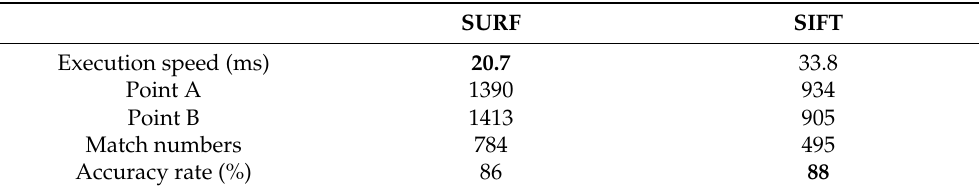
Table 1. We randomly selected two adjacent images for SIFT and SURF evaluation; point A refers to the number of feature points extracted from the previous image and point B refers to the number of feature points extracted from the latter image. SURF SIFT Execution speed (ms) 20.7 33.8 Point A 1390 934 Point B 1413 905 Match numbers 784